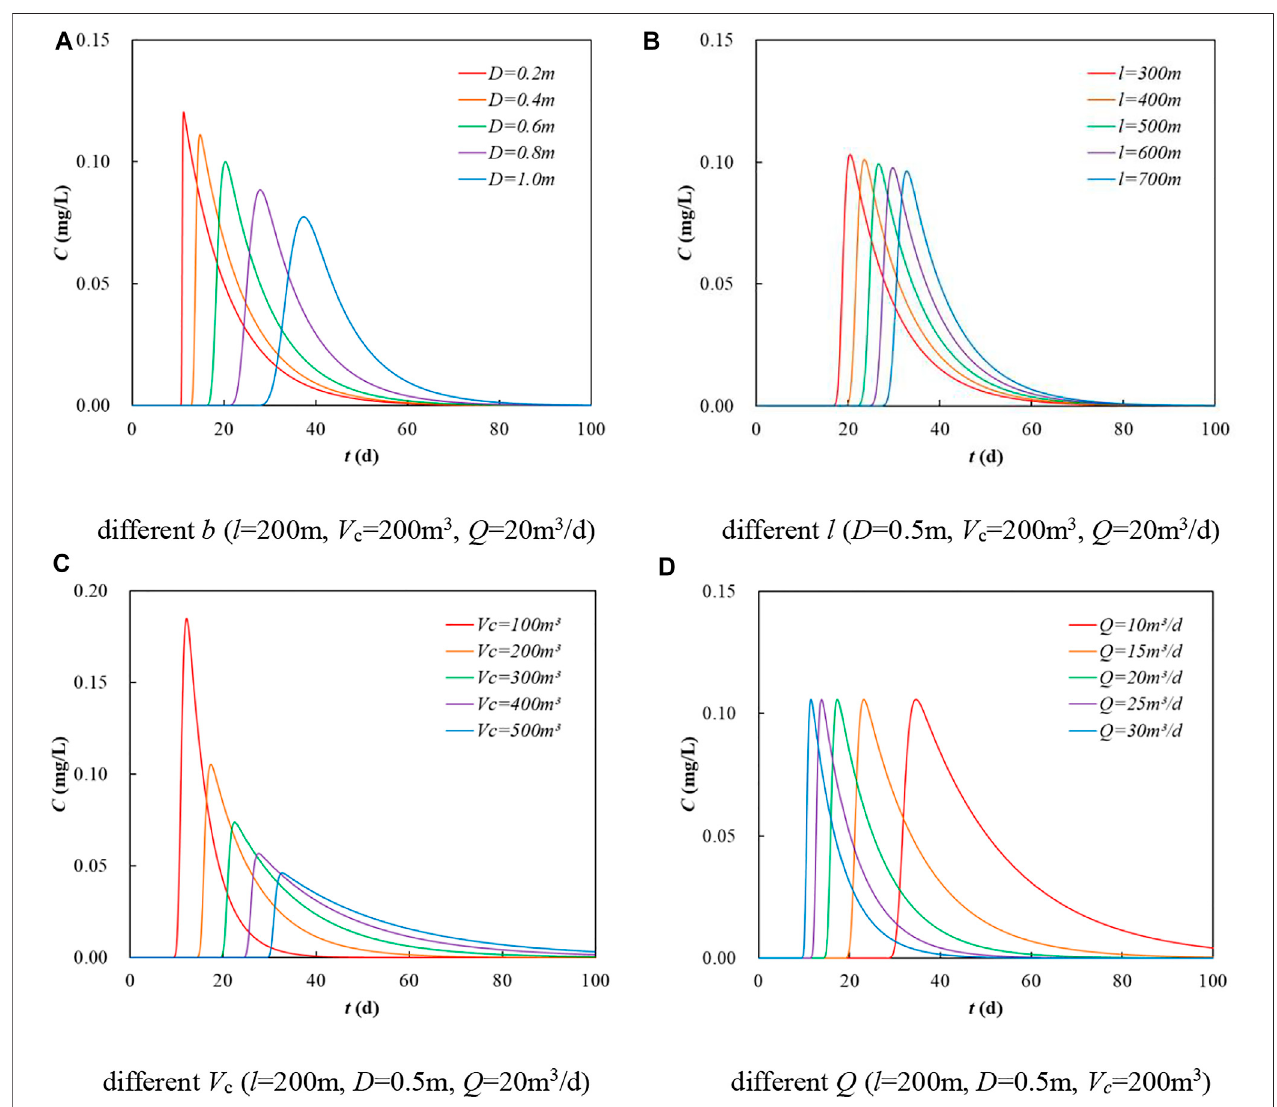
FIGURE 10 | Tracer output curve of interwell pipe series cavity under different parameters. (A) different b ( l =200 m, V c =200 m 3 , Q =20 m 3 /d) (B) different l ( D =0.5 m, V c =200 m 3 , Q =20 m 3 /d) (C) different V c ( l =200 m, D =0.5 m, Q =20 m 3 /d) (D) different Q ( l =200 m, D =0.5 m, V c =200 m 3